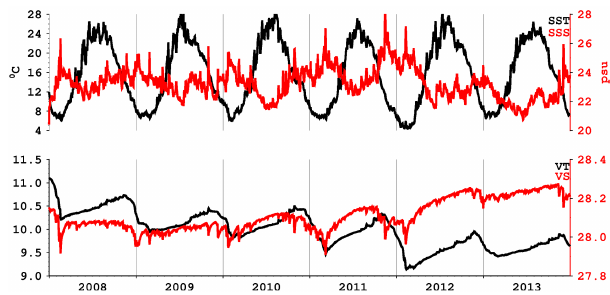
Figure 7. Daily time series of mean sea surface temperature (SST), mean sea surface salinity (SSS), volume mean temperature (VT) and volume mean salinity (VS) in the Sea of Marmara. Temperature and salinity are shown in black and red, respectively.